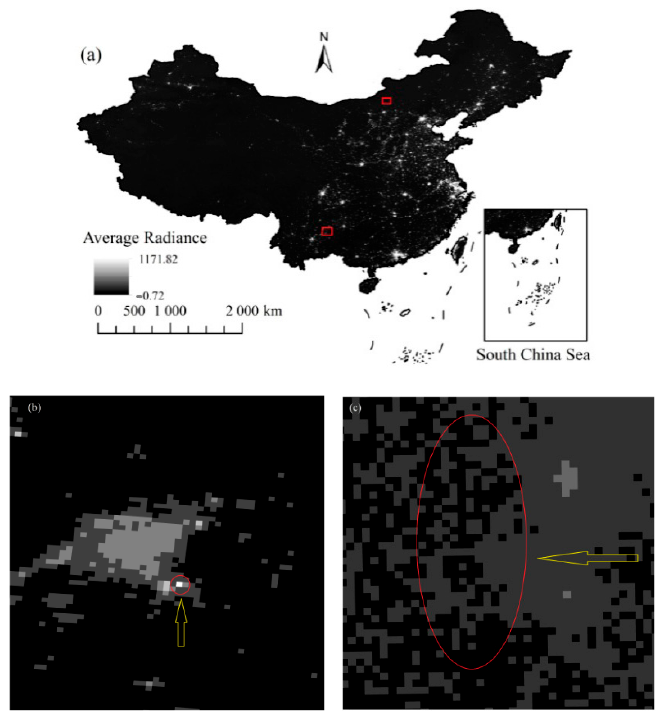
Figure 2. ( a ) The Soumi National Polar-Orbiting Partnership Visible Infrared Imaging Radiometer Suite (NPP / VIIRS) nighttime light image of china in January 2013. Two regions bounded by red rectangles are Huhehaote city, Heilongjiang province (sampling area No.1), and Yiwei city, Yunnan province (sampling area No.2); ( b ) the original image of sampling area No.1; ( c ) the original image of sampling area No.2.